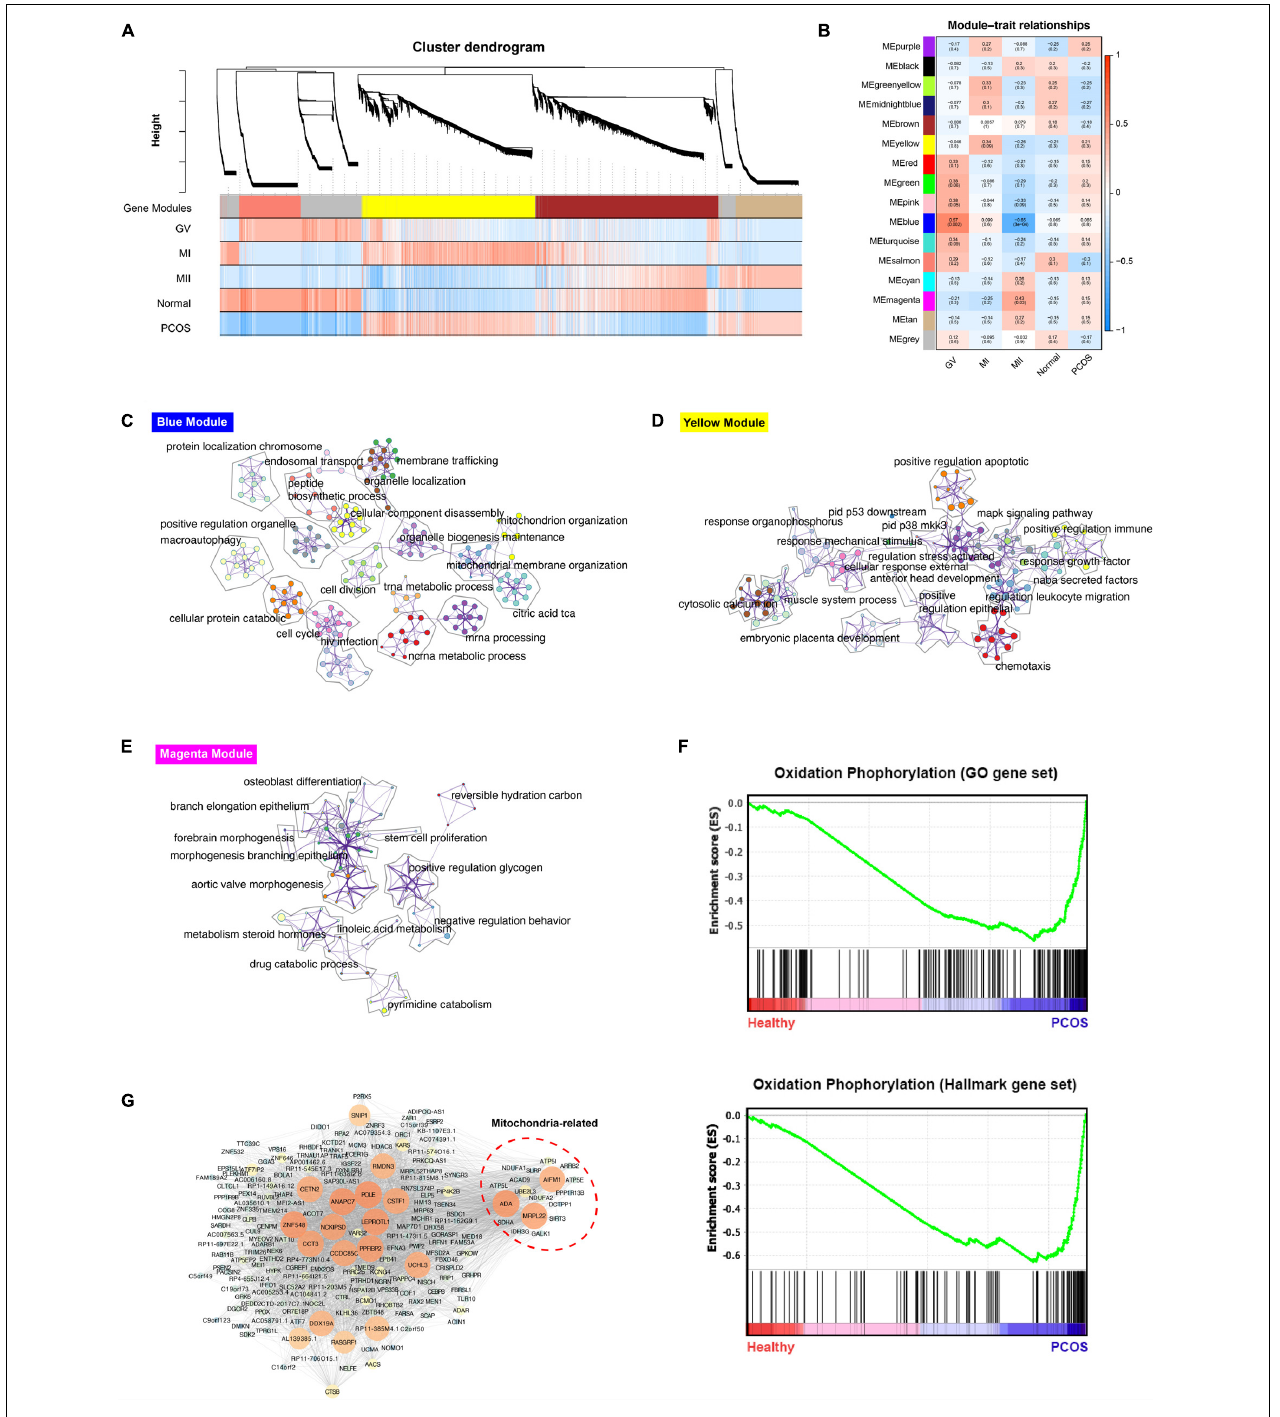
FIGURE 2 | WGCNA analysis of healthy and PCOS oocytes in different stages. (A) The dendrogram of gene modules built by WGCNA. Bars represent the correlation between genes in different developmental stage of oocyte and gene modules. Red means positively correlation and up-regulated at this stage; blue means negatively correlation and down-regulated at this stage. (B) Module-trait relationship between different gene modules. Number in each cell represent the degree of correlation, and red means positively correlation at this stage; blue means negatively correlation at this stage. Different colors represent the diverse specific gene modules detected by WGCNA. C-E. Network of enriched GO terms of genes containing in blue module (C) , yellow module (D) and magenta module (E) separately, colored by GO cluster ID. (F) The results of Gene set analysis (GESA) for hallmark gene sets (up) and GO biological processes gene set (down). The enrichment score (ES) means value of maximum deviation from 0 of the running sums and each line on the button represent the different genes of gene set. (G) Co-expression network of hub genes containing in blue module illustrated by the Cytoscape. The large size and the bright color of nodes represented high MCODE score of genes.